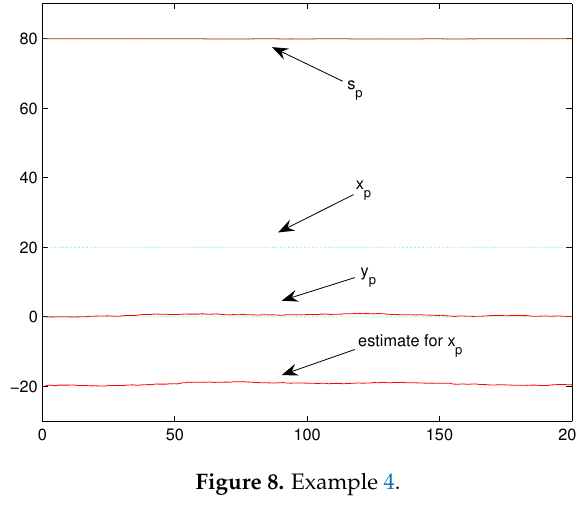
Figure 8. Example